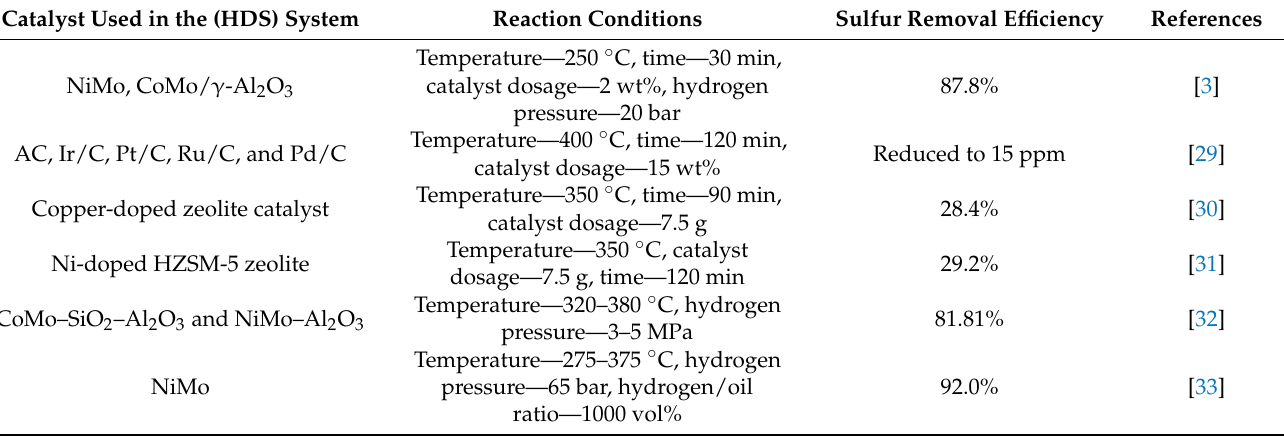
Table 2. Ultimate analysis of WTPO.